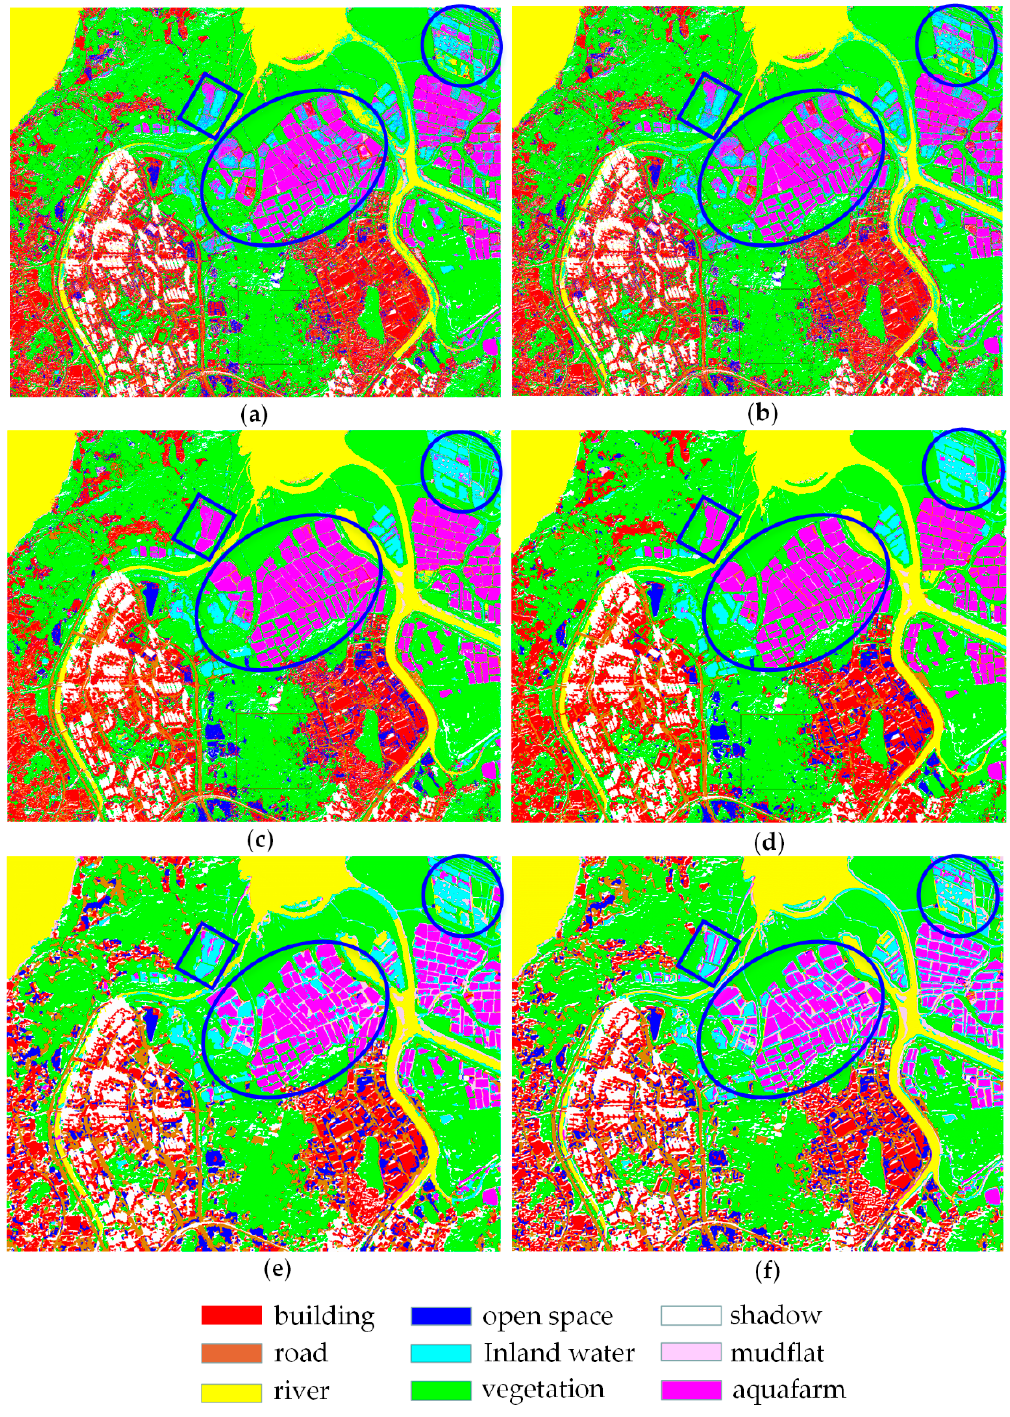
Figure 5. Classification results of the six methods. ( a ) Raw; ( b ) SS; ( c ) OSS; ( d ) OSS-MSSC; ( e ) VGG; ( f ) VGG-MSS.